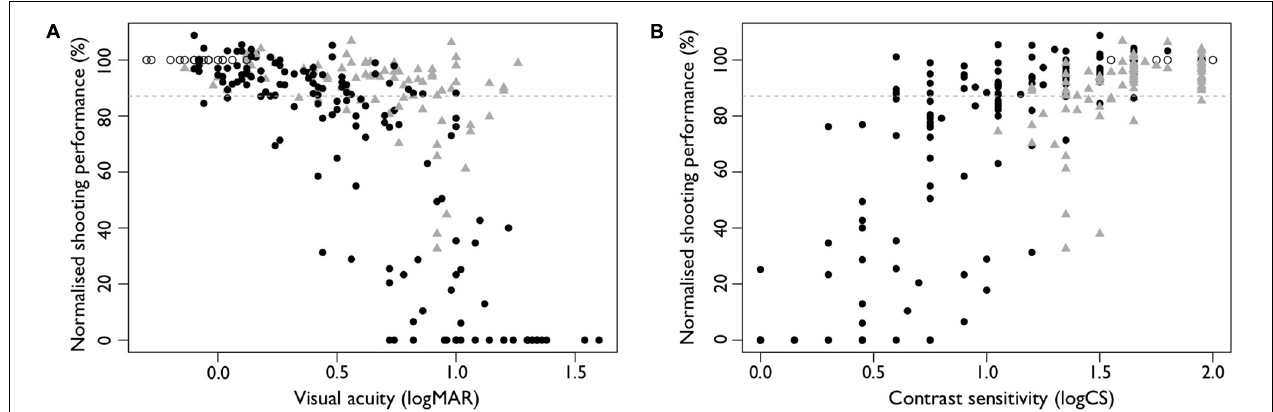
FIGURE 2 | Normalized shooting performance as a function of (A) visual acuity and (B) contrast sensitivity in the habitual condition (open circles), with simulated vision impairment by use of filters (filled circles) and by use of refractive blur (gray filled triangles). The cut-off below which shooting performance was considered ‘below expected’ is represented by the gray dashed